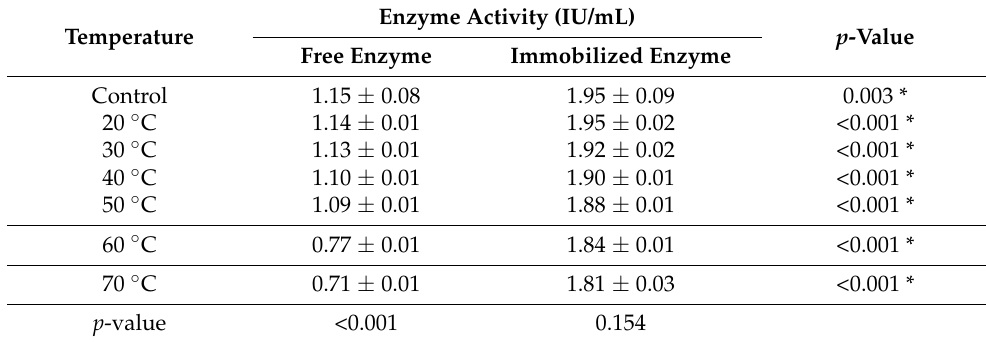
Table 1. The thermal stability of free and immobilized CMCase produced by A. niger under SmF.